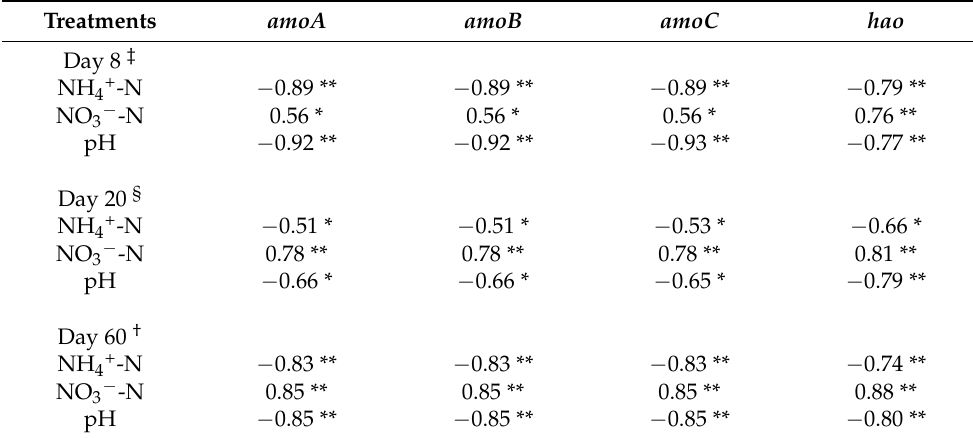
Table 6. The Spearman’s correlations (r) between soil properties and nitrification genes at different incubation times for Qidong (QD) soil. Treatments amoA